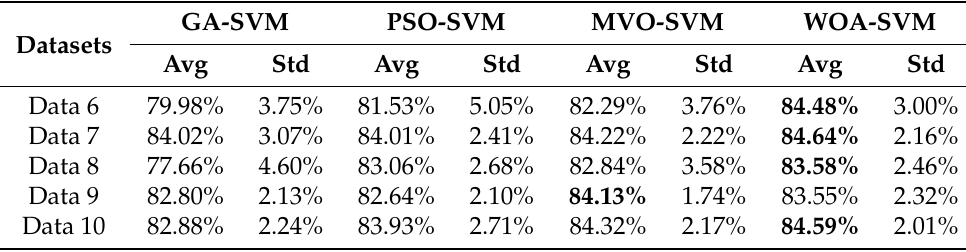
Table 11. F-measure results of GA-SVM, PSO-SVM, WOA-SVM, and MVO-SVM for Latter-rules